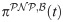
Mean-field model: Representation of the 4 forward and backward transitions of the configuration associated with the state variable πPNP,B(t), with the corresponding transition rates.The transition rates computed thanks to Ass. (H4) are highlighted with a colored background.